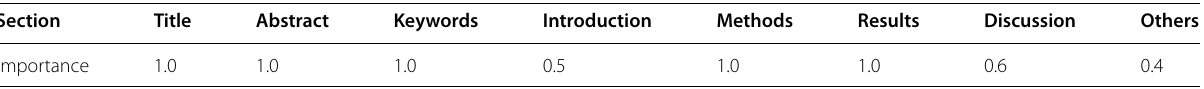
Table 2 List of different sections considered in publications along with their relative importance for the modeling. “Summary” is considered synonymous with Abstract and “Conclusions” with Discussion. “Others” include Acknowledgments and References as well as any additional